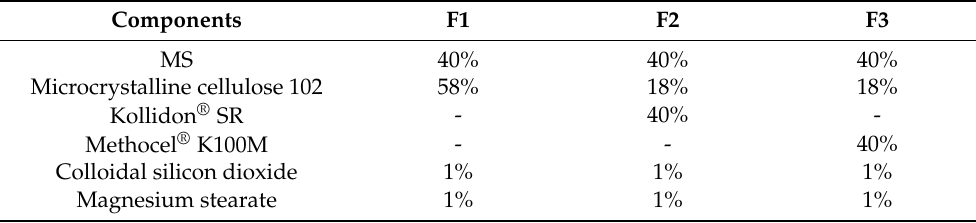
Table 1. Composition of the MS mini-tablet